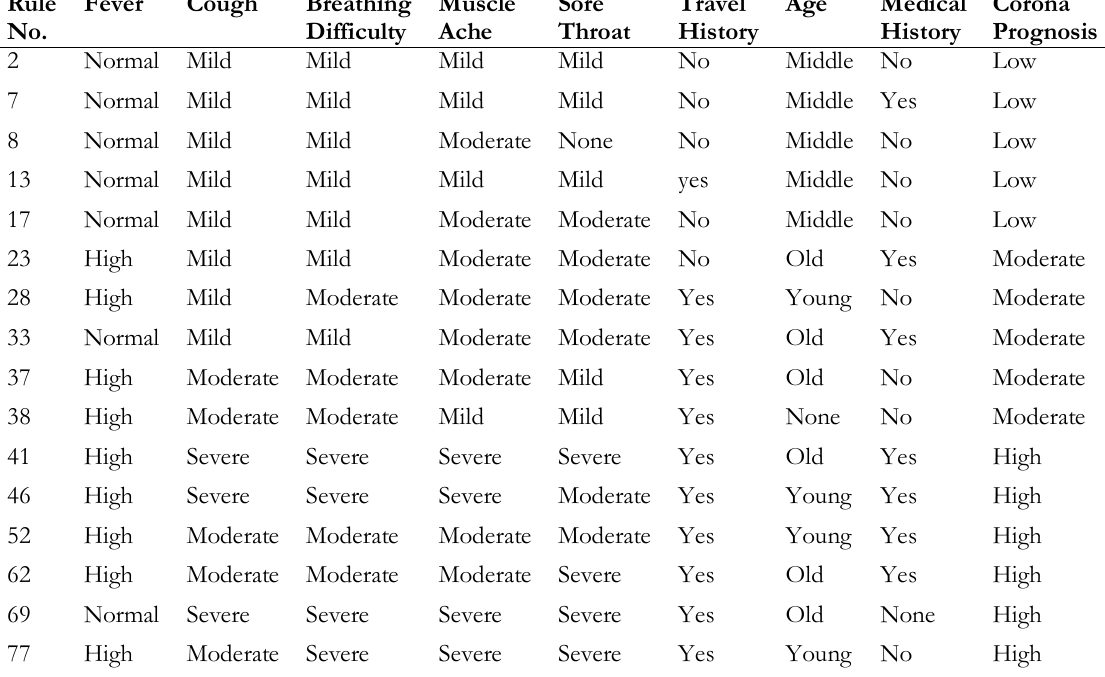
Table 4. Some of the defined rules of